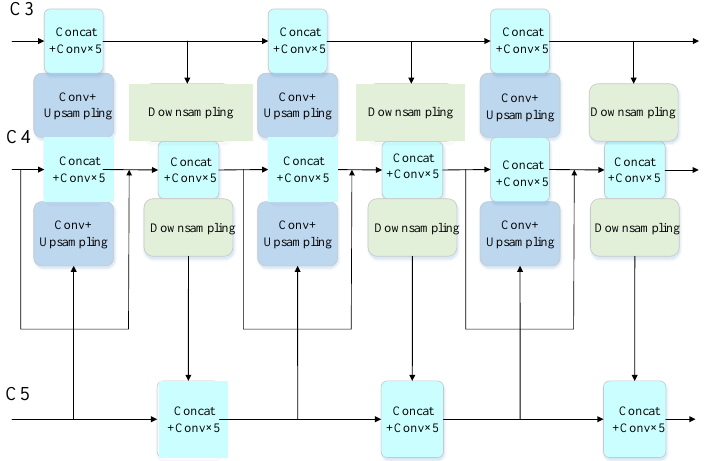
Figure 4. The structure of enhanced feature network BiFPN.